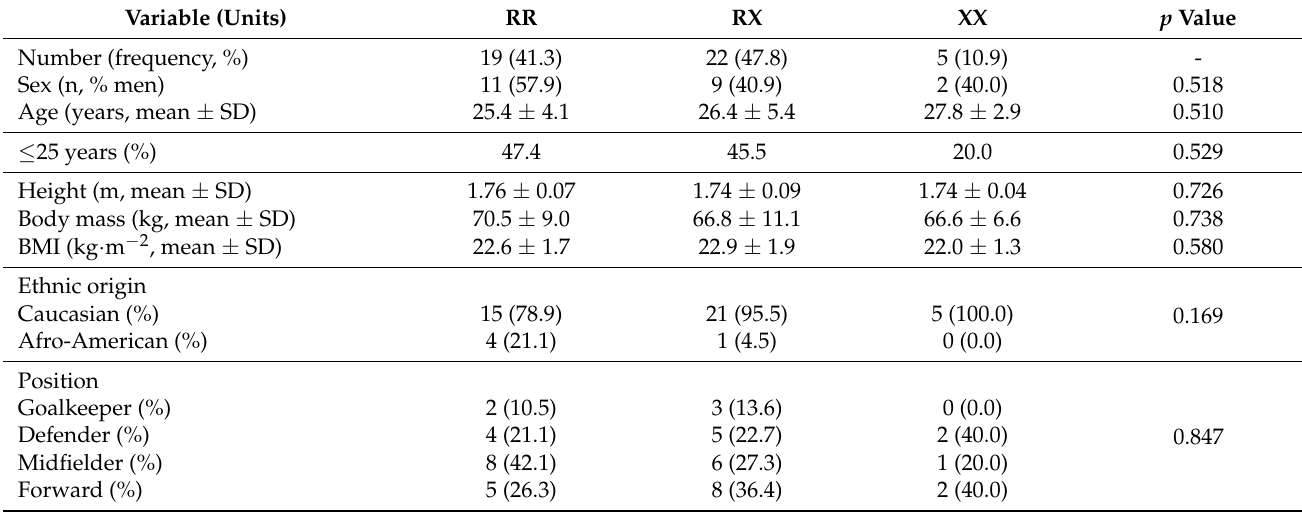
Table 1. Main characteristics of the participants by α -actinin-3 gene ( ACTN3 ) R577X